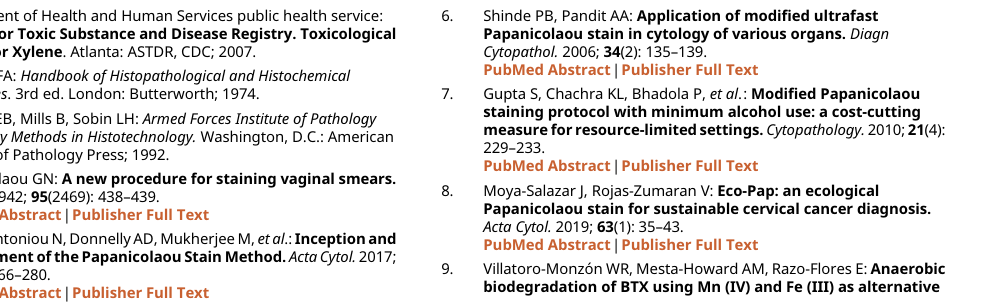
Figshare: ‘ Cost and pollution by the use of xylene in cervical cytology in four Peruvian hospitals ’ , https://doi.org/10.6084/m9.figshare.14615508.v1 13